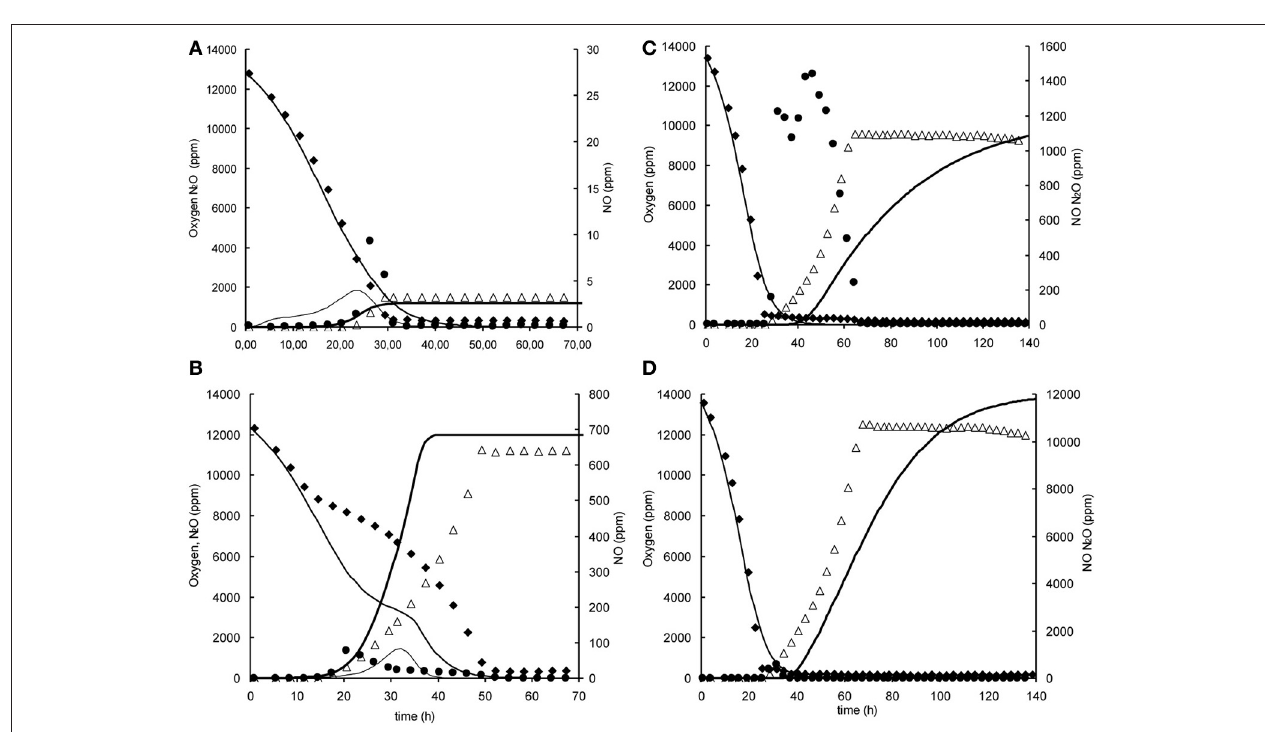
nitrite and nitrate in the liquid phase at 0.2 and 2mM. (A) 1% oxygen, 0.2mM nitrite. (B) 1% oxygen 2mM nitrite. (C) 1% oxygen, 0.2mM nitrate. (D) 1% oxygen, 2mM